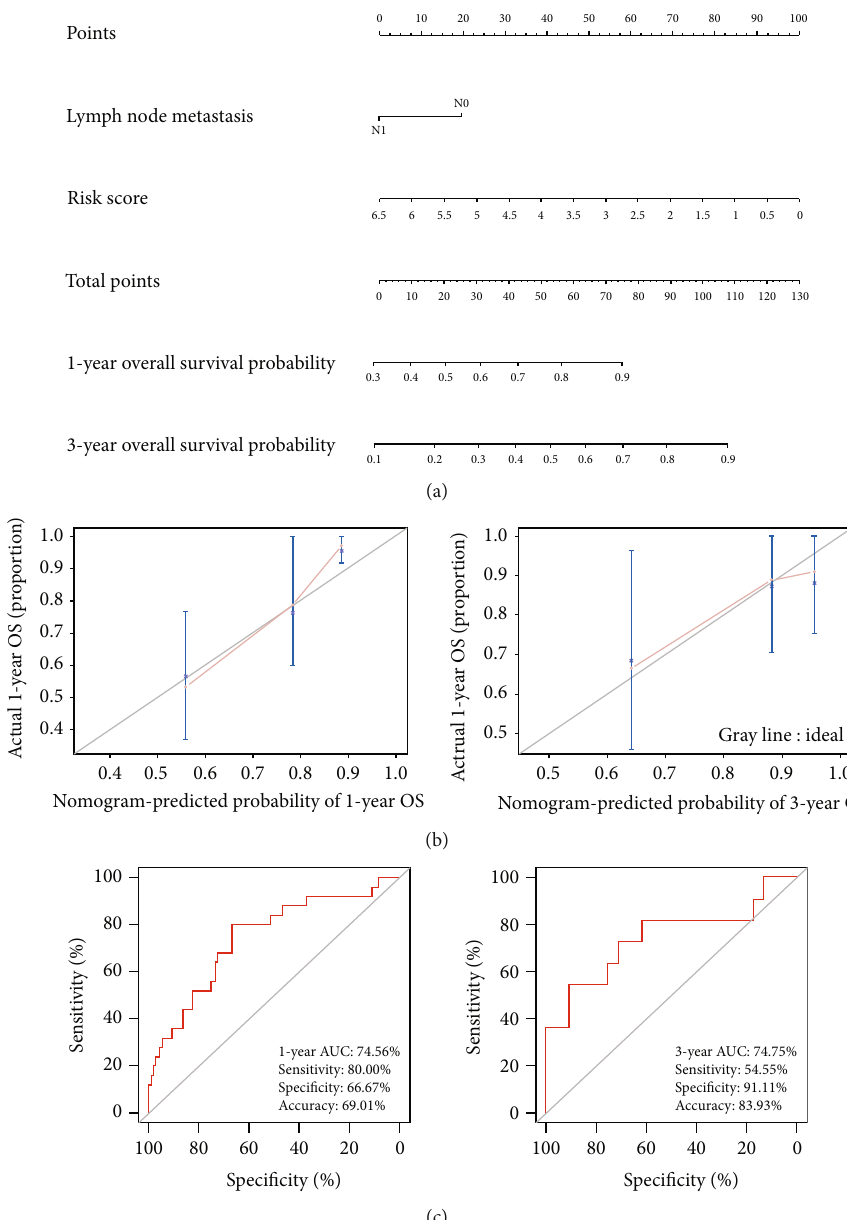
Figure 7: Analysis of the nomogram for predicting OS among patients with CC. (a) Nomogram of two independent risk factors (four-gene signature and LNM status); the scores for each variable were added to obtain the total score for predicting the 1- and 3-year OS of patients with CC. (b) Calibration plots for the nomogram predicting 1-year OS ( n = 142 ) and 3-year OS ( n = 56 ). The reference line represents a perfect match between the predicted and actual survival probabilities. (c) AUC of the ROC curve verifying the prognostic accuracy of the nomogram for predicting 1- and 3-year OS. AUC: area under the curve; CC: cervical cancer; LNM: lymph node metastasis; OS: overall survival; ROC: receiver operating